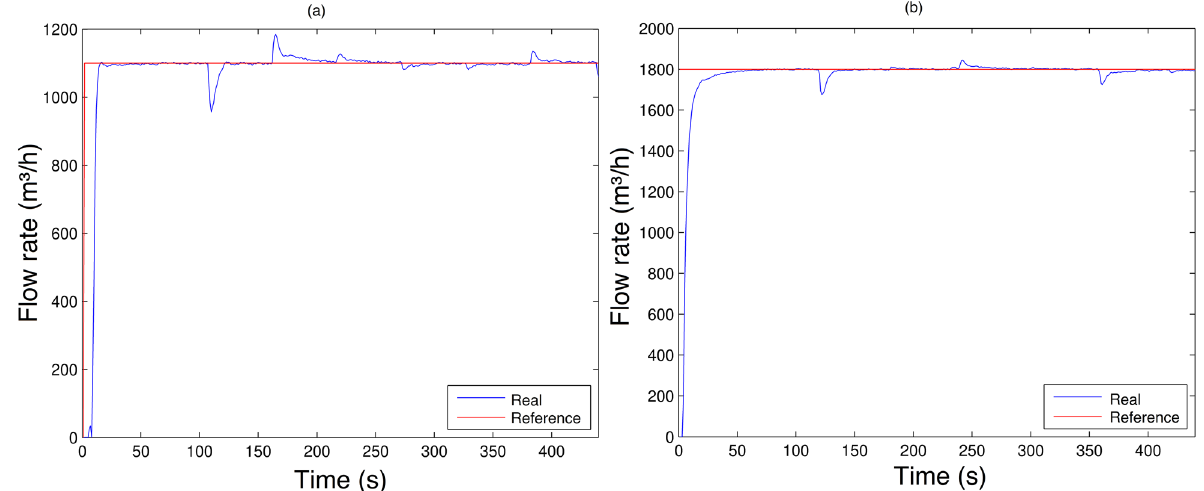
Figure 24. ( a ) Controller robustness assessment (desired flow rate in 1100 m 3 / h ); ( b ) Controller robustness assessment (desired flow rate in 1800 m 3 / h